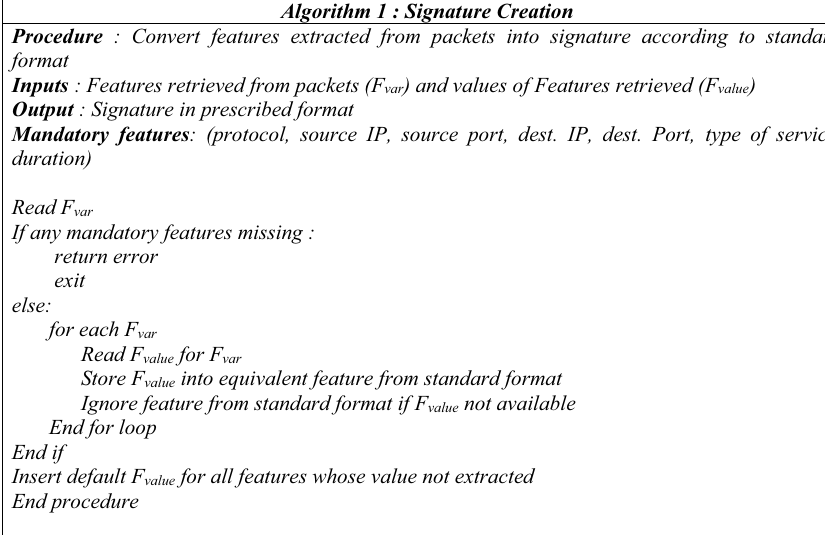
Algorithm 1 : Signature Creation Procedure : Convert features extracted from packets into signature according to